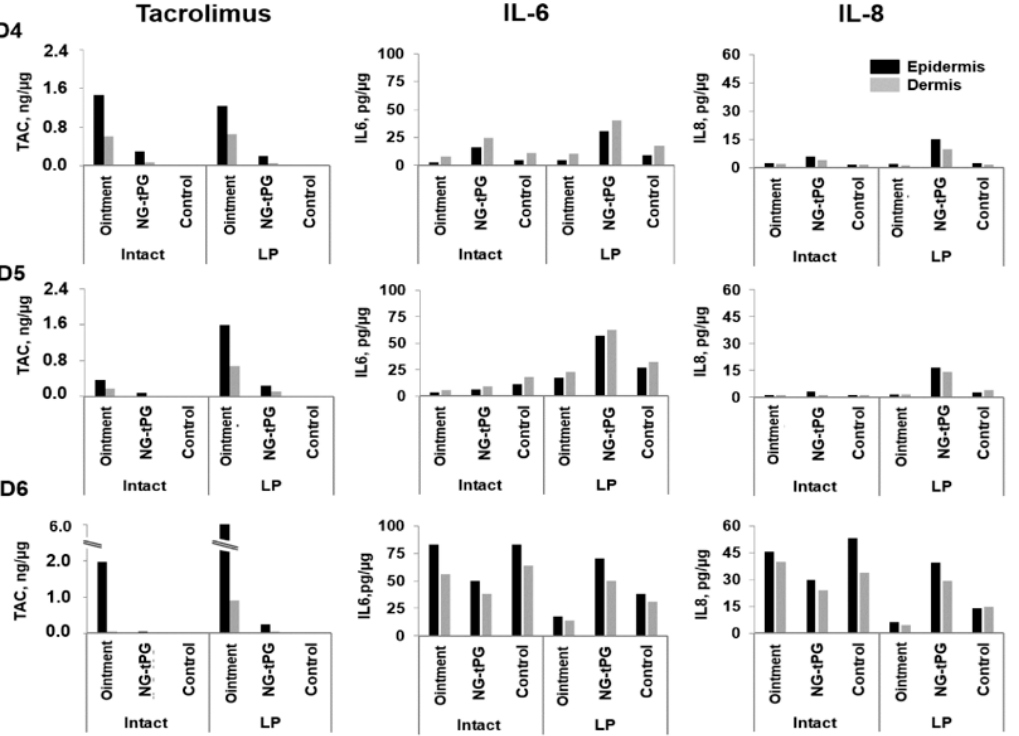
Figure 1. Tacrolimus skin penetration and expression of the inflammatory cytokines IL-6 and IL-8 after topical application of tacrolimus ointment or nanogel formulation (tacrolimus final dosage 5 µg/cm 2 ) on breast skin from three different donors (D4–6). Skin barrier was left intact or treated with LP prior to the application of the test formulations. Control skin was treated with 0.9% NaCl solution. TAC: tacrolimus; LP: laser poration; NG-tPG: nanogels based on thermoresponsive polyglycerol.